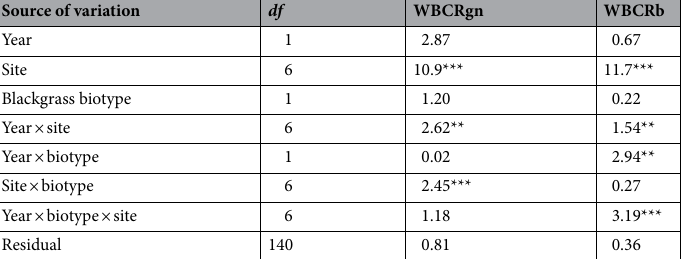
Table 3. Mean squares from the three-way analysis of variance for the competitive ratio of winter wheat (W) and herbicide-resistant or herbicide-susceptible blackgrass (B) calculated for the relative grain number (WBCRgn) and plant biomass (WBCRb). df degrees of freedom. * P < 0.05; ** P < 0.01; *** P <